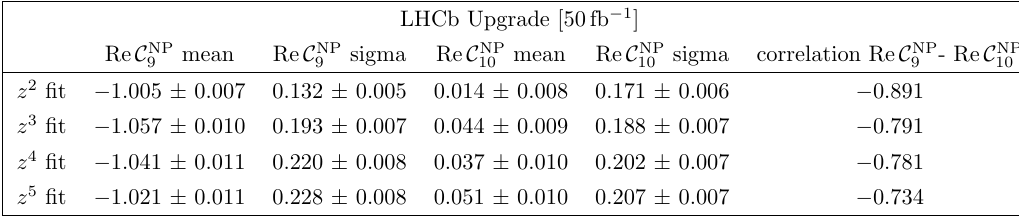
and C NP for z 2 , z 3 , z 4 and z 5 (cid:12)ts. Ensembles are 9 10